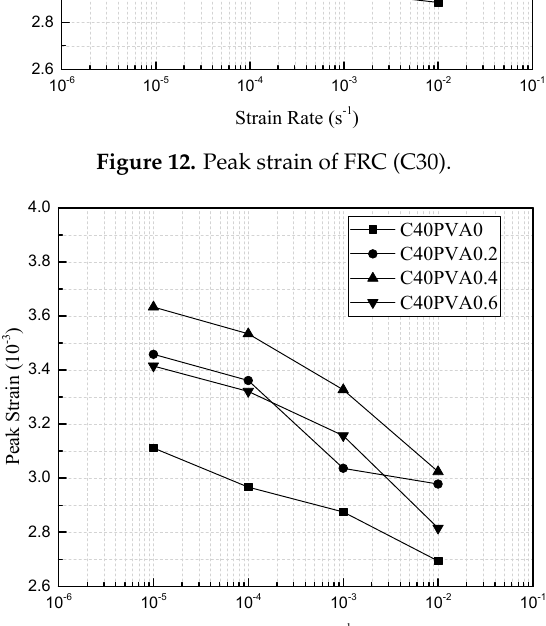
Figure 13. Peak strain of FRC (C40).